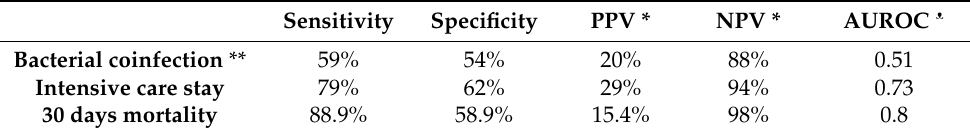
Table 4. Performance of the procalcitonin test in hospitalized patients with seasonal influenza.